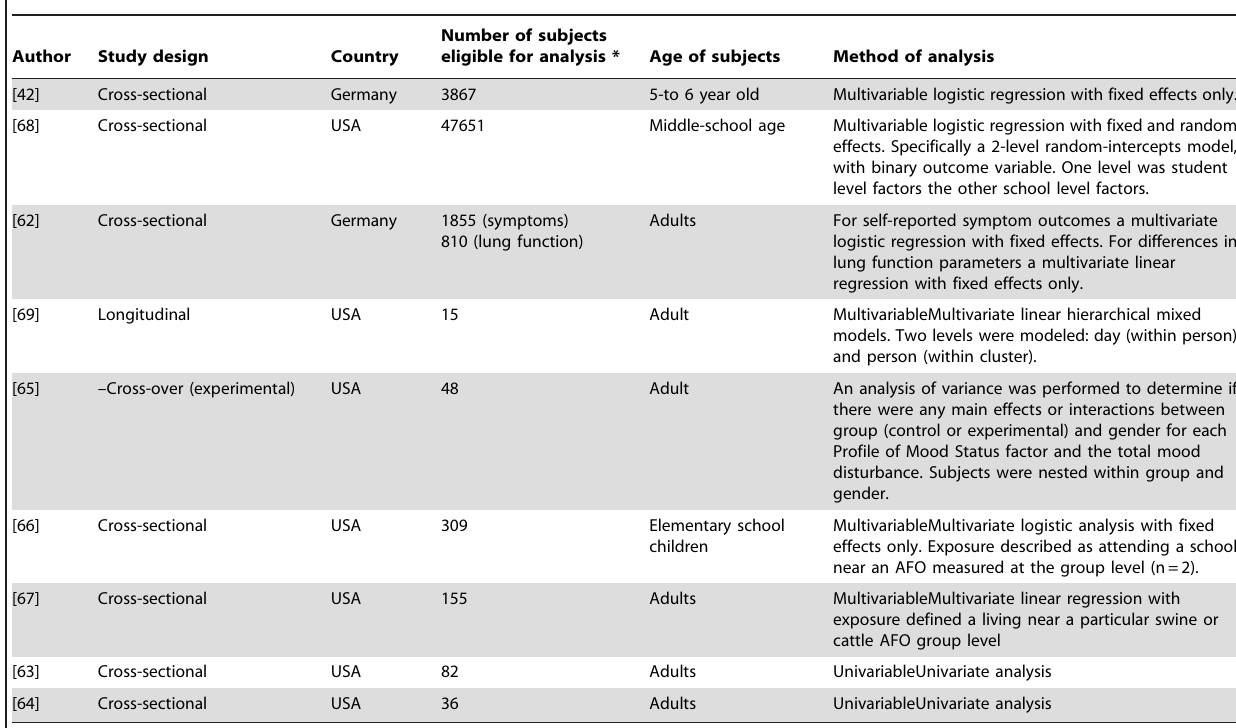
Table 1. Summary information for